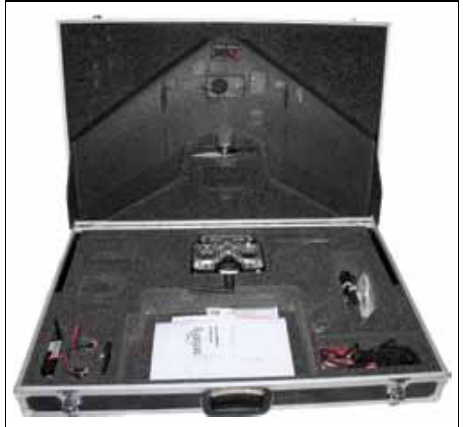
Fig. 7: The rugged carrying case for the UAV (mounted in the lid) and its supporting equipment, making it easy to